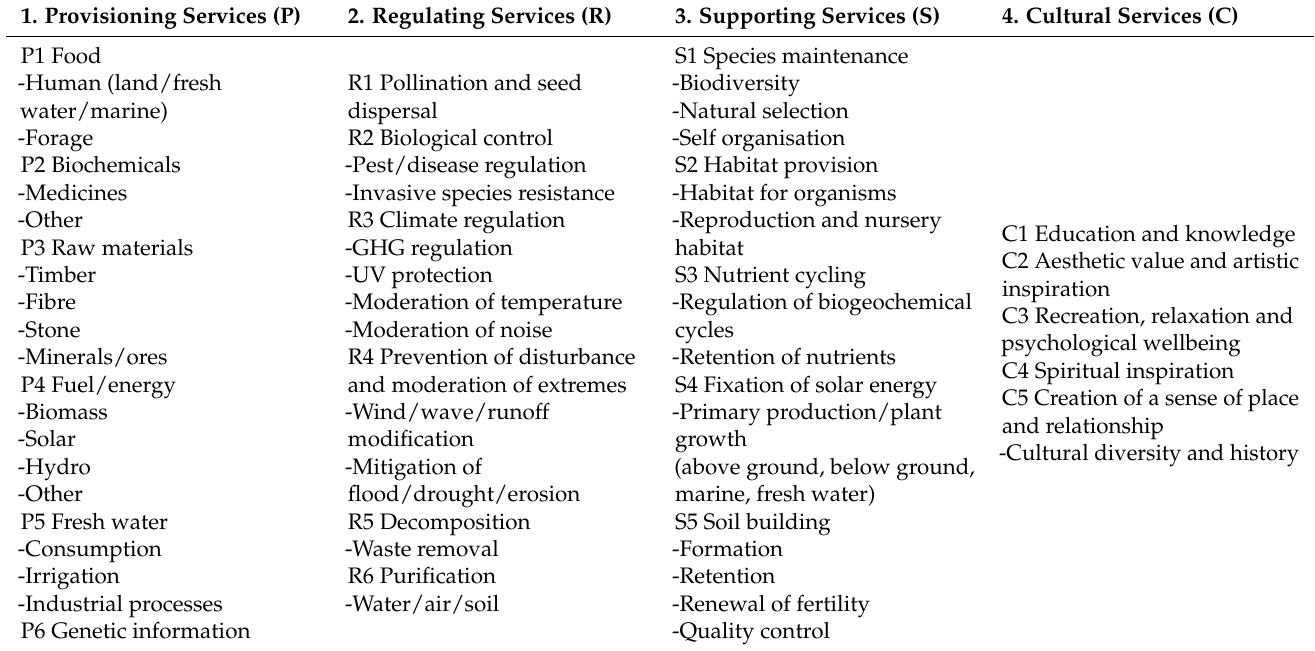
Table 1. Ecosystem services with reference to an urban context (source: